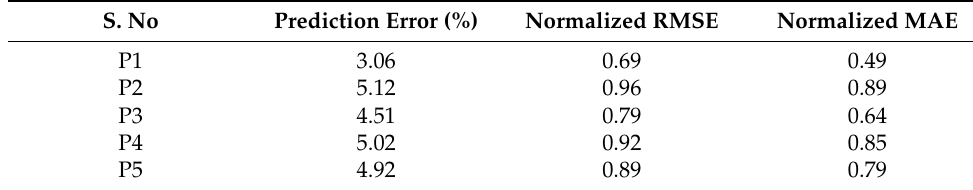
Table 1. LSTM results for P1–P5.